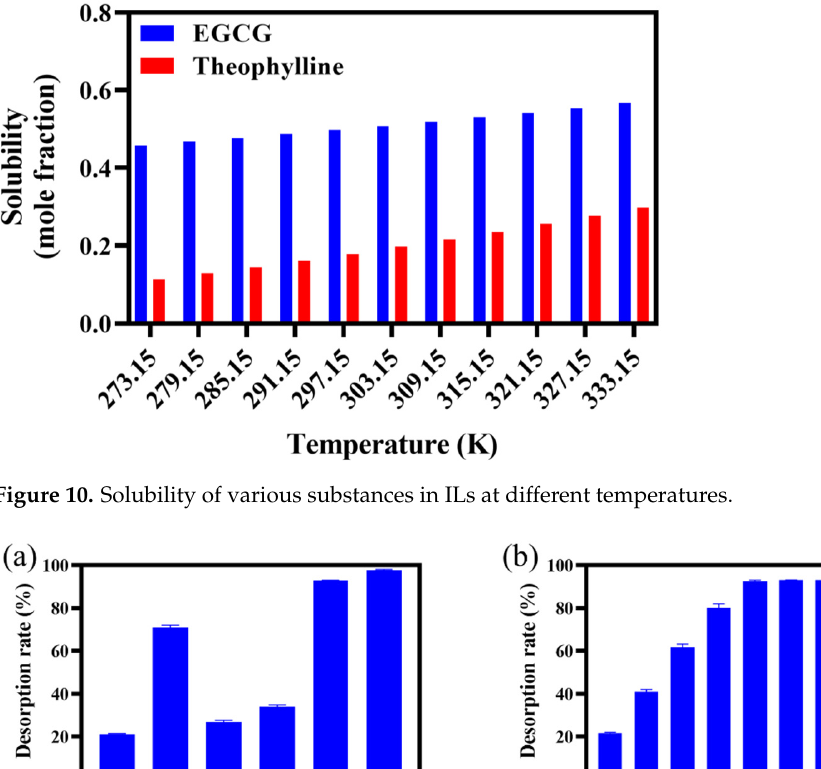
Figure 11. The desorption efficiency of EGCG under various desorption solvents ( a ) and time ( b ). The A, B, C, D, E and F indicates ethyl acetate, methanol, ethanol, 5% aqueous hydrochloric acid, 2% methanol hydrochloric acid and 5% methanol hydrochloric acid, respectively.